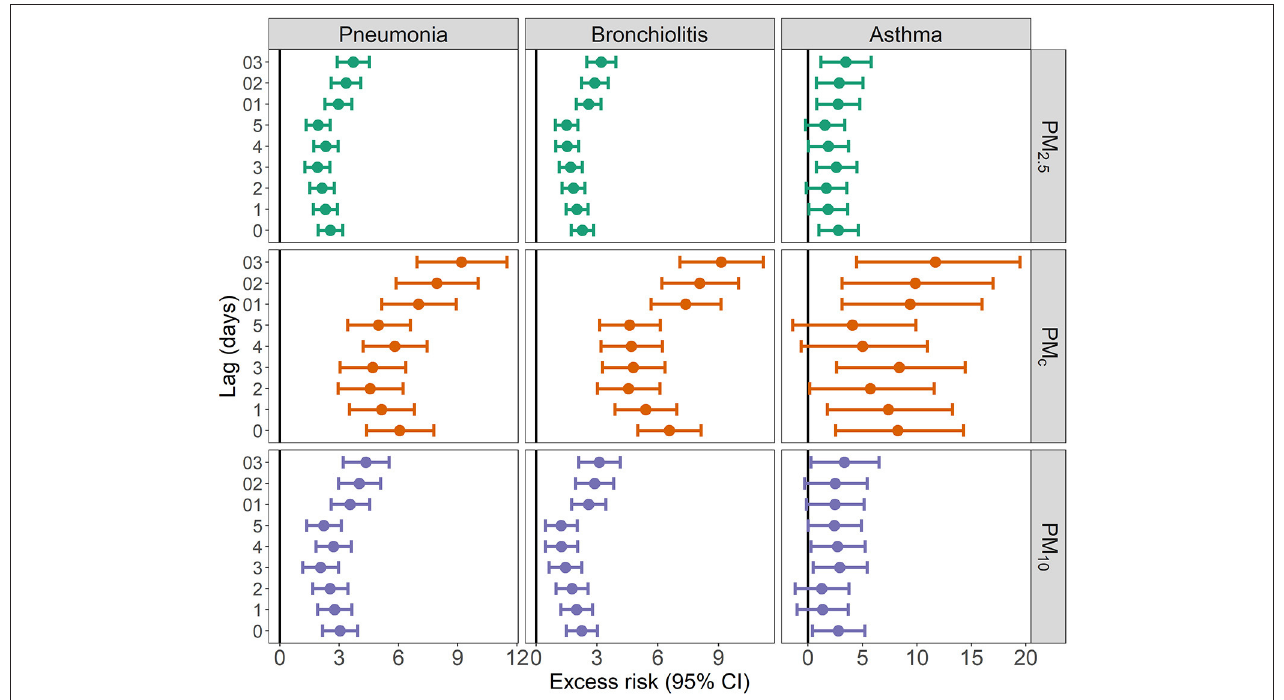
FIGURE 3 | Excess risk (95% CIs) of hospital outpatient visits associated with 10 µ g/m 3 increase in PM 10 , PM c , and PM 2.5 .